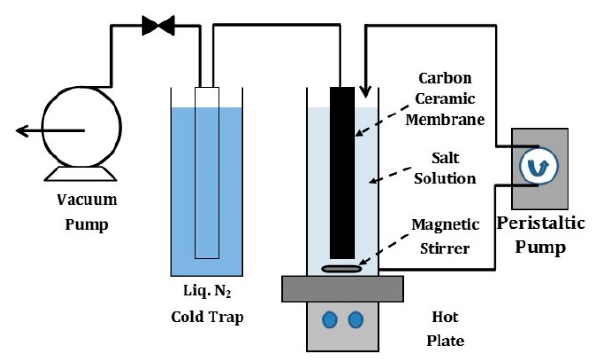
Figure 2. Schematic of the pervaporation experimental set up.